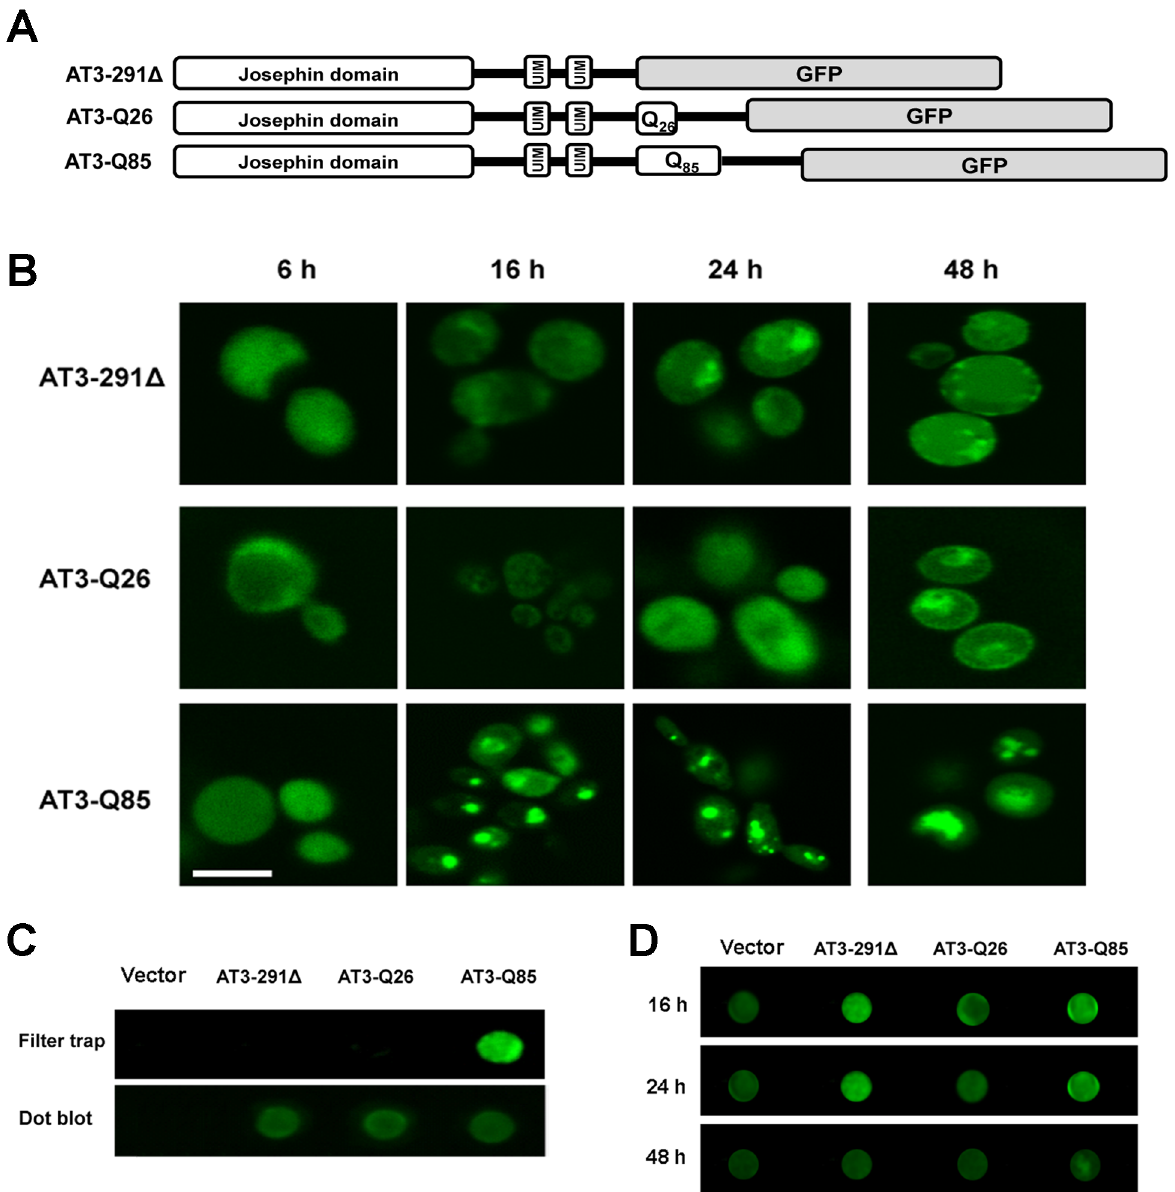
Fig 1. Morphological analysis of AT3 aggregation. A) Sequence and domain organization of the AT3 variants under investigation. UIM: ubiquitin interacting motif, GFP: green fluorescent protein. B) Cells expressing the indicated AT3-GFP fusion proteins were analyzed by fluorescence microscopy (Scale bar: 10 μ m) at the indicated times of induction. C) Whole protein extracts of the three strains after 24 h of induction were subjected to filter trap analysis to detect SDS-insoluble aggregates. The immunodecoration was performed using anti-AT3 antibody and anti-rabbit fluorescent secondary antibody. Dot-blot analysis was performed as a loading control. D) Whole protein extracts of S . cerevisiae strains expressing the AT3 variants were subjected to dot blot at different times after induction and immunodetected using OC antibody and anti-rabbit fluorescent secondary